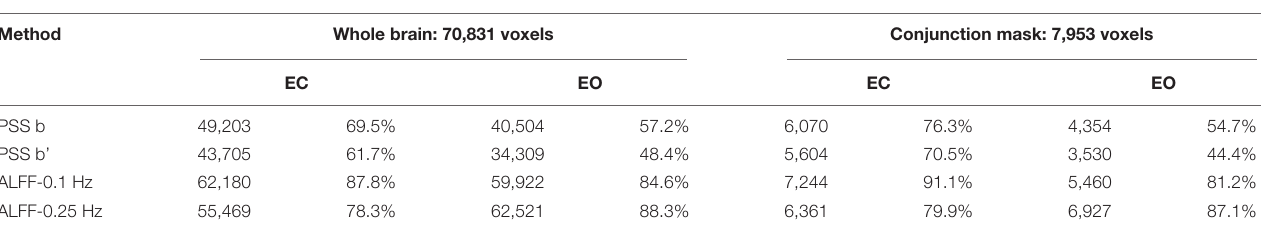
FIGURE 12 | ICC histograms of coefficient b and power-law slope b’ and ALFF under EC and EO conditions using group Z-transformation. Panels (A,B) show the histograms of ICC values of EC (A) and EO (B) conditions from the entire brain. Panels (C,D) show the histograms of ICC values of EC (C) and EO (D) conditions from the conjunction mask of the voxels that survived GRF correction from EC–EO differences. TABLE 2 | Test–retest reliability with group